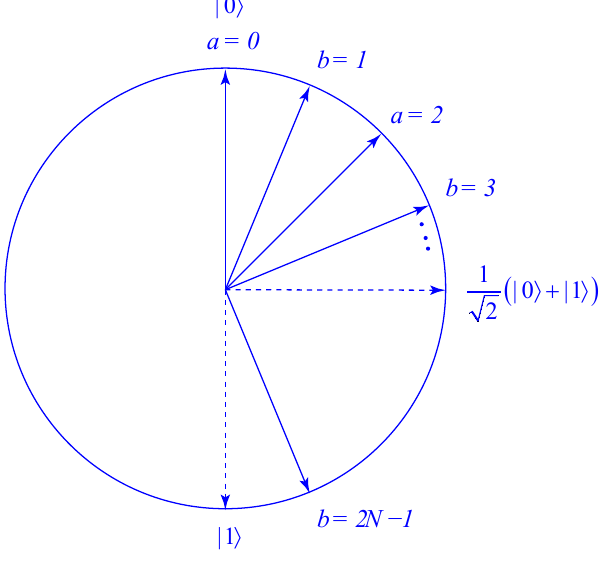
Figure 14: The structure of the correlation measure given in Eq. (230) . A solid line between a and b represents the probabil- Figure 15: Alice and Bob’s measurement bases represented on ity that the outcomes of M A and M A are di ff erent and a dotted a b a great circle of the Bloch line represents the probability that they are the same. The correlation measure is then the sum of the terms represented by each line.